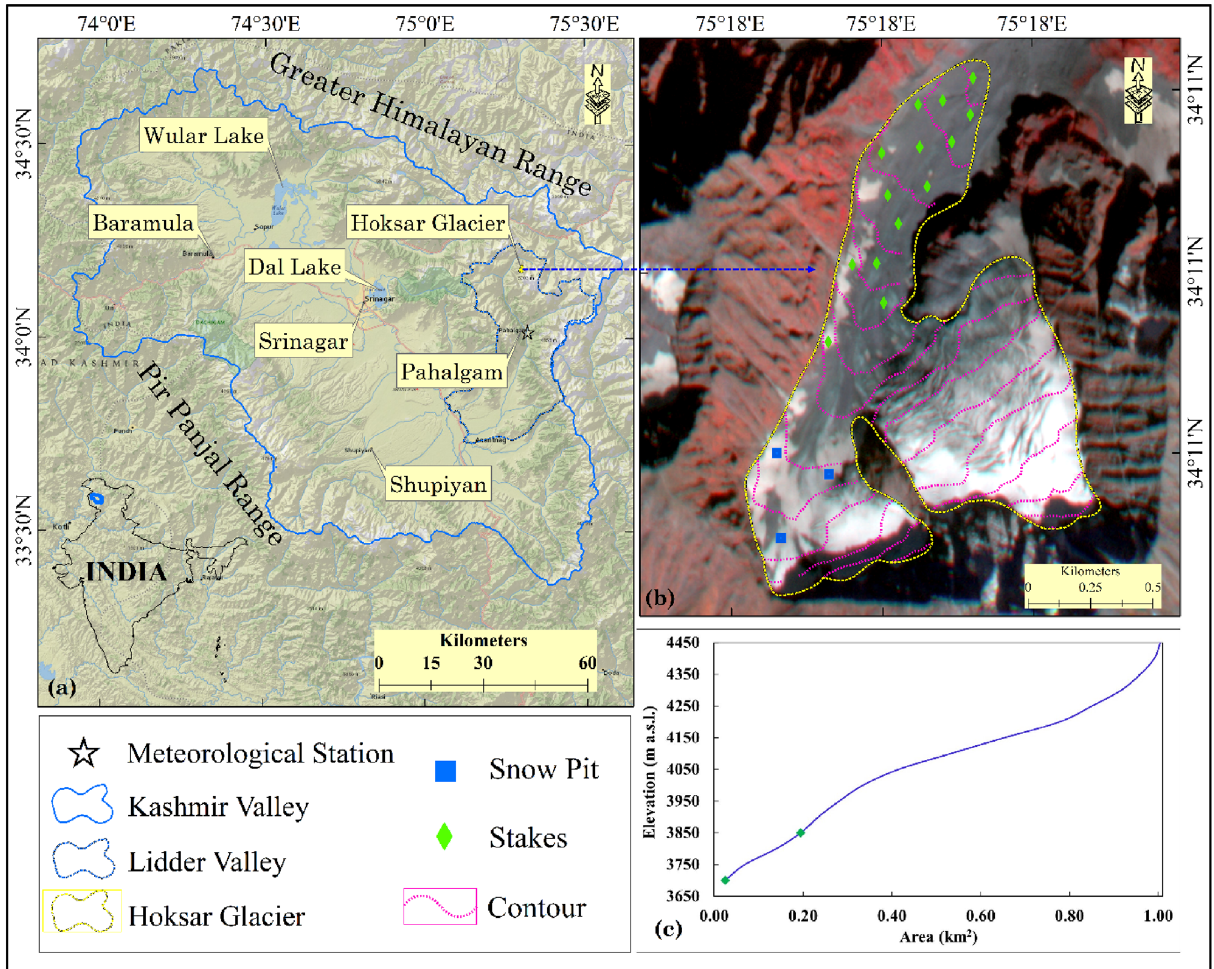
Figure 1. ( a ) Map showing the location of the Kashmir valley (blue color boundary) with respect to India country map, Lidder valley (dotted dark blue color) and other key landmarks including the Hoksar Glacier (dotted yellow color) and location of the meteorological station at Pahalgam (star). ( b ) Satellite imagery of the Hoksar Glacier showing the contour lines generated from SRTM DEM (dotted pink color), distribution of debris-cover, location of stakes (green diamond boxes), accumulation pits (blue square boxes), and ( c ) Cumulative hypsometric curve of the HG, two green dots depict the glacier area with a thick debris-cover. Maps ( a , b ) were generated in ArcGIS version 10.4.1 (https:// www. esri. com) by utilizing the imageries provided by National Geographic, Esri and Planet Labs dated 23rd Sep 2019, respectively, ( c ) hypsometric curve was plotted using Microsoft office excel 2019.